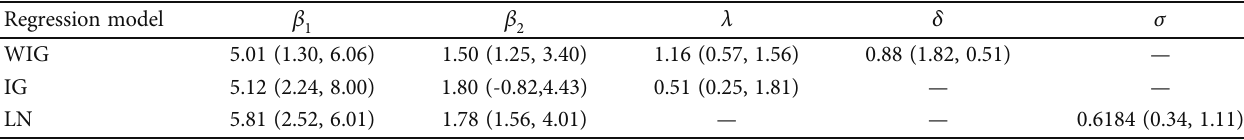
Table 5: The Bayes estimates and 95% HPD credible intervals of regression coe ffi cients for WIG model along with corresponding values for IG and LN models.